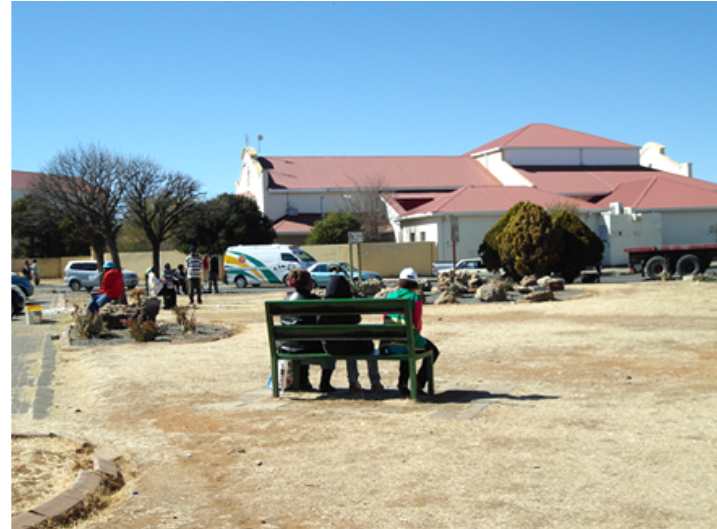
Figure 6. In diurnal spatial practice. Source: photograph by